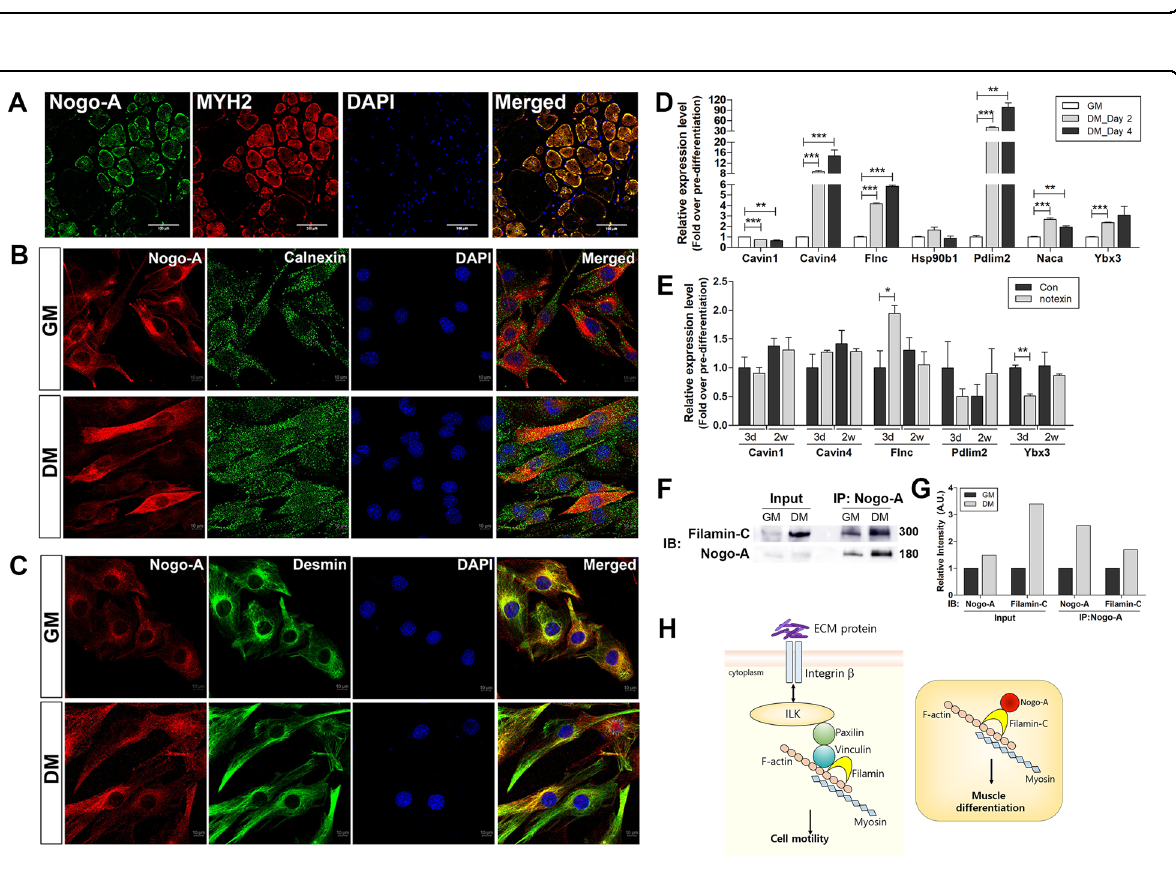
Fig. 7 Location of Nogo-A in mature skeletal muscle and C2C12 myoblasts, and identi fi cation of Nogo-A interacting factors during differentiation. A – C Localization of Nogo-A in mature skeletal muscle and C2C12 myoblasts. A Isolated gastrocnemius muscles from 8-week-old C27BL/6 mouse were sectioned and stained for Nogo-A (green) and MYH2 (red). Scale bar = 100 µm. B IF staining of Nogo-A (red) and calnexin (ER protein, green) in growth-conditioned C2C12 cells. Scale bar = 10 µm. C IF staining of Nogo-A (red) and desmin (muscle-speci fi c, type III intermediate fi lament, green) in differentiation-conditioned C2C12 cells. Scale bar = 10 µm. D – F Expression levels of Nogo-A-interacting molecules suggested by immunoprecipitation-mass spectrometry analysis of differentiated C2C12. qRT-PCR analysis of indicated genes in C2C12 cells cultured with DM for 2 or 4 days ( D ) and in muscles after 3 days or 2 weeks of notexin injury ( E ). F Immunoprecipitation with a Nogo-A-speci fi c antibody was performed using lysates of C2C12 cells maintained in GM or DM for 4 days. WB analysis of indicated proteins in immunoprecipitated samples. Molecular weights (kDa) are indicated. G Quantitative assessment of band intensities of blots in F using the NIH ImageJ software. H Filamin-mediated cell motility regulation and proposed model of Nogo-A ’ s role in muscle differentiation via its interaction with fi